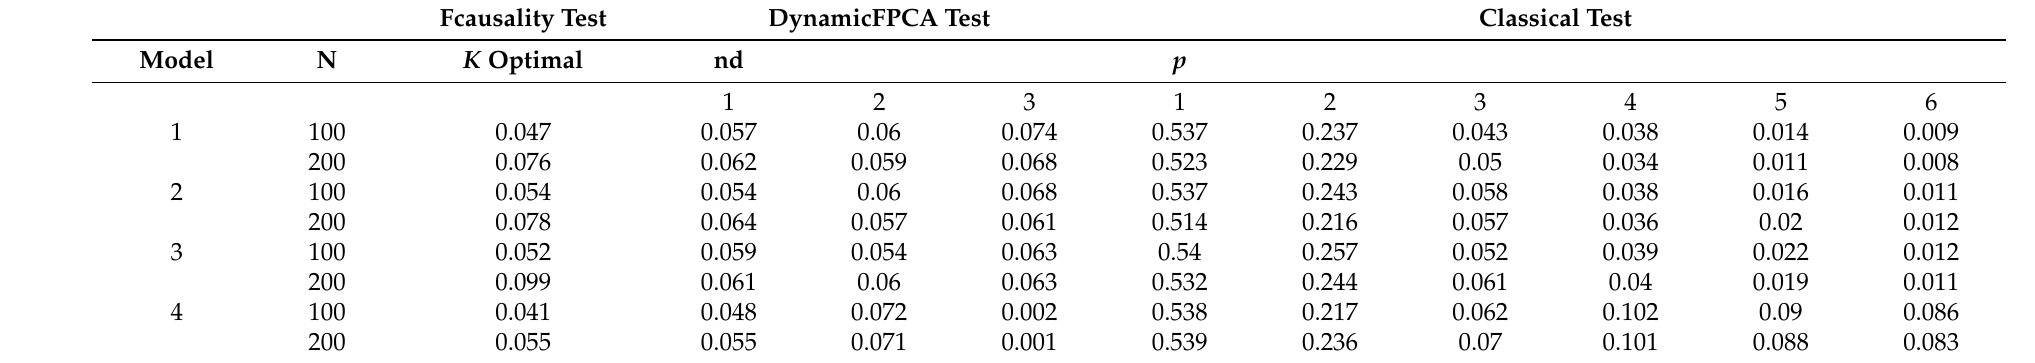
Table 2. Nominal Level 0.05.